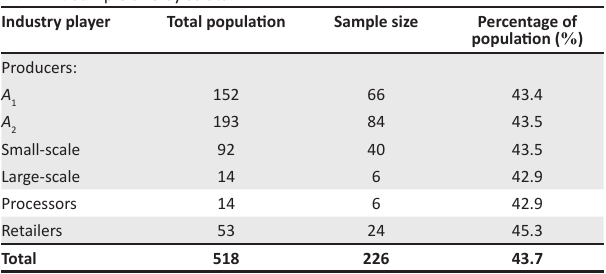
FIG URE 1: Geographical location of Mashonaland Central province. TABLE 1: Sample size by